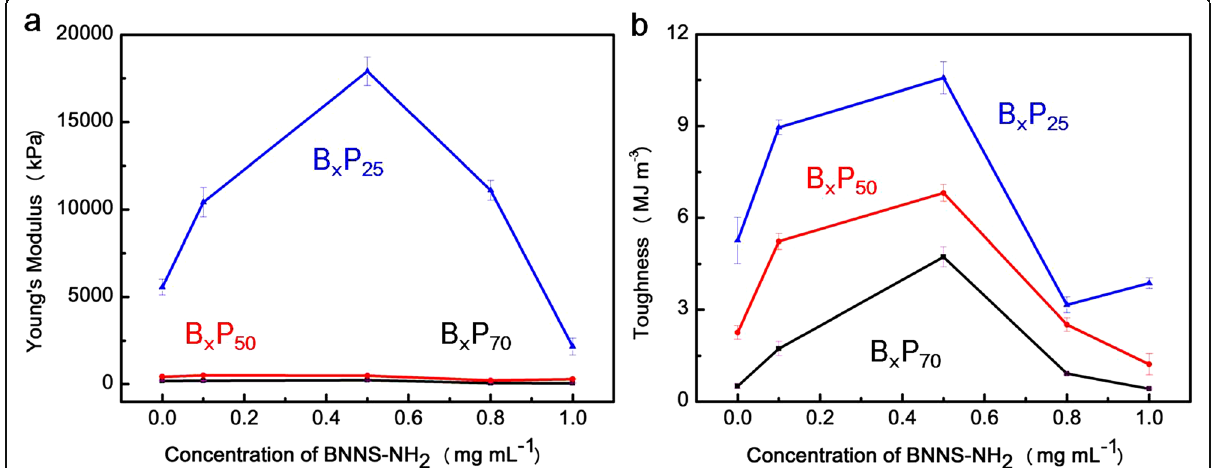
Fig. 5 a Young ’ s modulus and b toughness of composite hydrogels with different water contents and BNNS-NH 2 concentrations